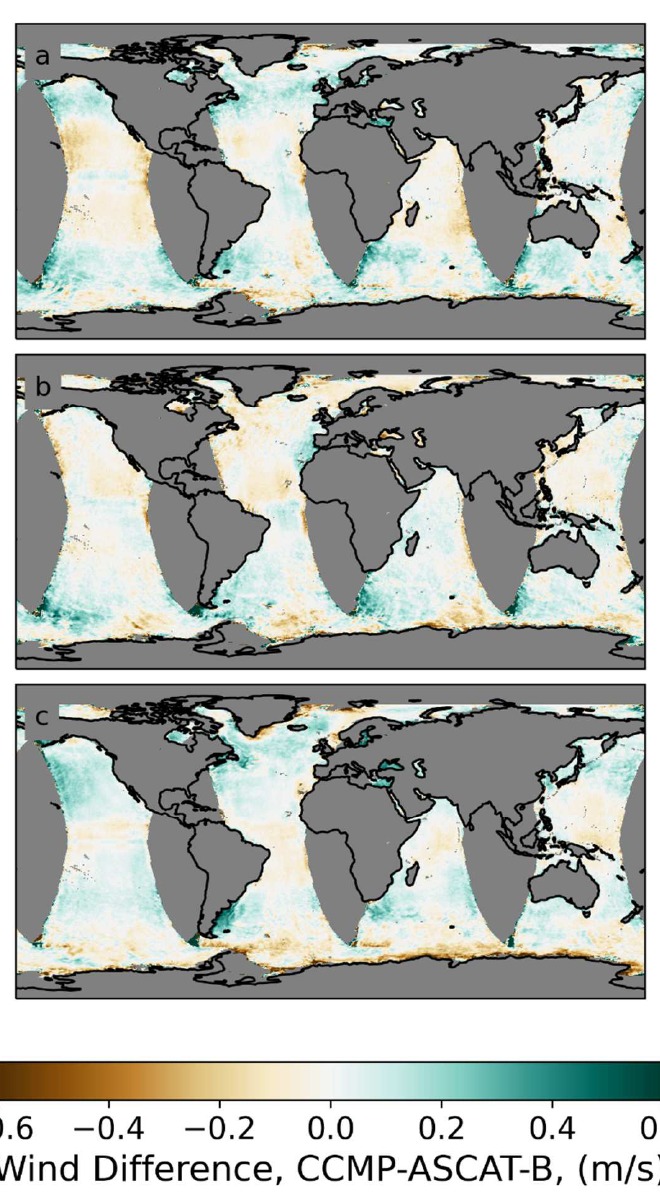
Figure 11. Maps ( a ), Zonal Wind; ( b ), Meridional Wind; ( c )-Wind Speed of mean difference between CCMP ERA5 ADJ. vs. ASCAT-B, averaged over the 2013–2019 period. These maps were made using all rain-free ASCAT-B collocations and are intended to serve as an estimate of the performance of the CCMP ERA5 ADJ wind product.